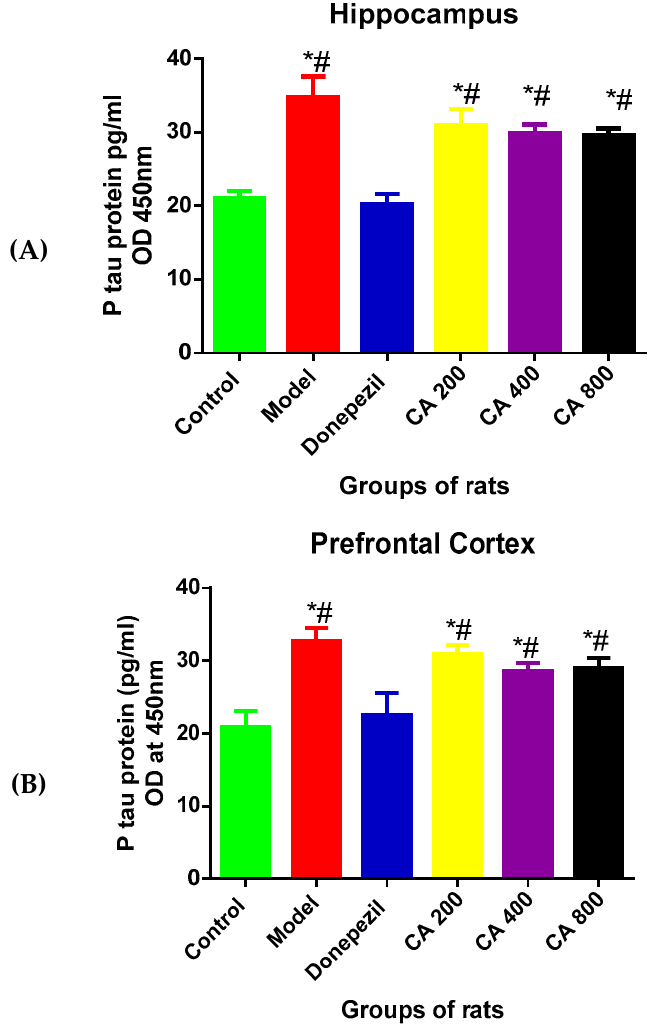
Figure 3. Effects of CA on the levels of P-tau in the hippocampus and cerebral cortex of rat’s administered with D-gal and AlCl 3 . ( A ) Hippocampus, ( B ) cerebral cortex. Data were presented as mean ± SEM, n = 3. * p < 0.05 vs. control group, # p < 0.05 vs. model group.